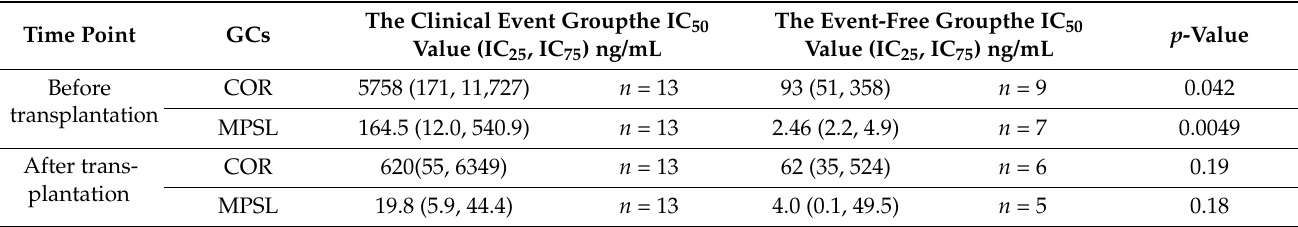
Table 2. Comparison of the 50% of PBMC proliferation (IC 50 ) values between the clinical event group and the event-free group regarding experience of increase/resumption of GCs Time Point